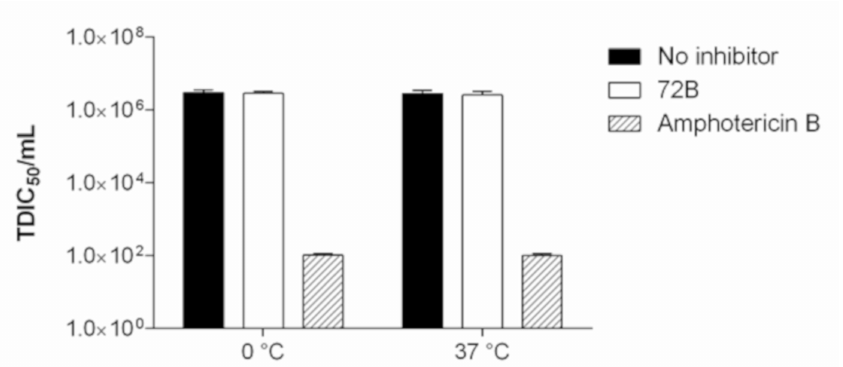
Figure 2. Virucidal e ff ect (expressed as median tissue culture infectious dose (TCID 50 / mL) of 72B (30 µ g / mL) against HIV-1 wt at either 0 ◦ C or 37 ◦ C for 2 h. Dark columns represent viral titer for viral control solution, white columns represent 72B treated solution, and line pattern columns represent amphotericin B treated solution. The results p resented were obtained from three independent experiments. Data are mean ± SD.